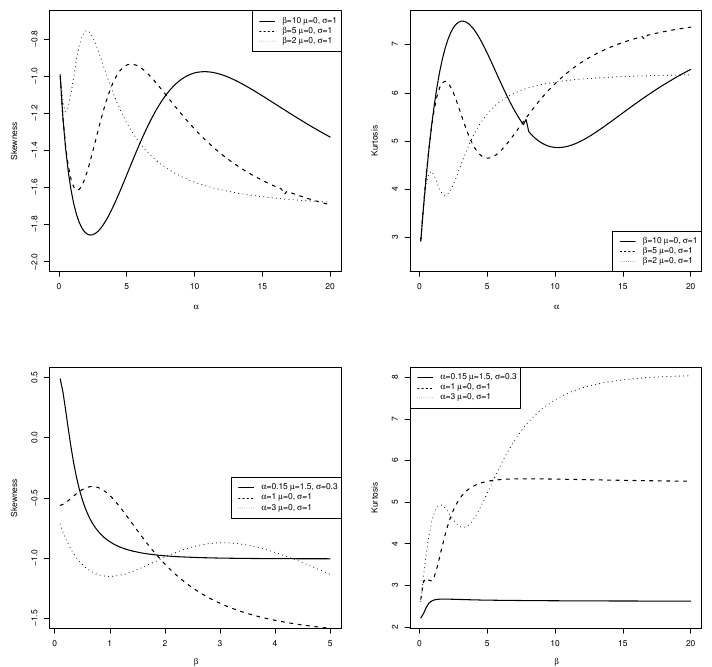
Figure 4. The skewness and kurtosis plots for the selected AOLLOW-N